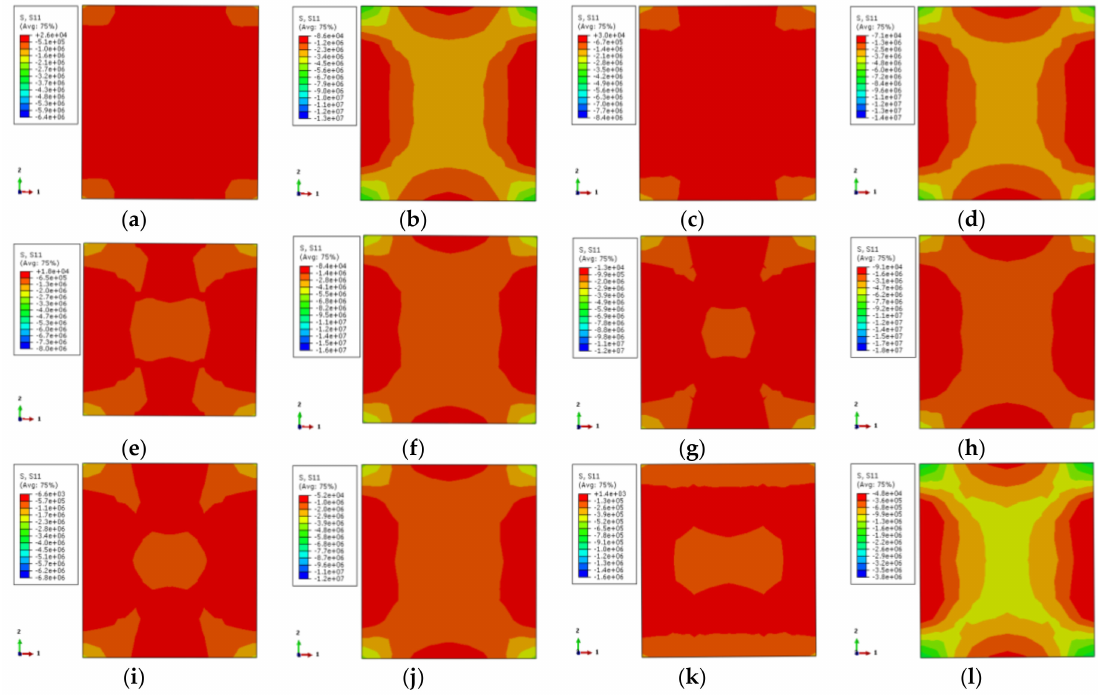
Figure 12. The lateral stress distribution of concrete ( a ) DS-20-0.75; ( b ) DS-20-1; ( c ) DS-100-0.75; ( d ) DS-100-1; ( e ) DS-200-0.75; ( f ) DS-200-1; ( g ) DS-400-0.75; ( h ) DS-400-1; ( i ) DS-600-0.75; ( j ) DS-600-1; ( k ) DS-800-0.75; ( l )